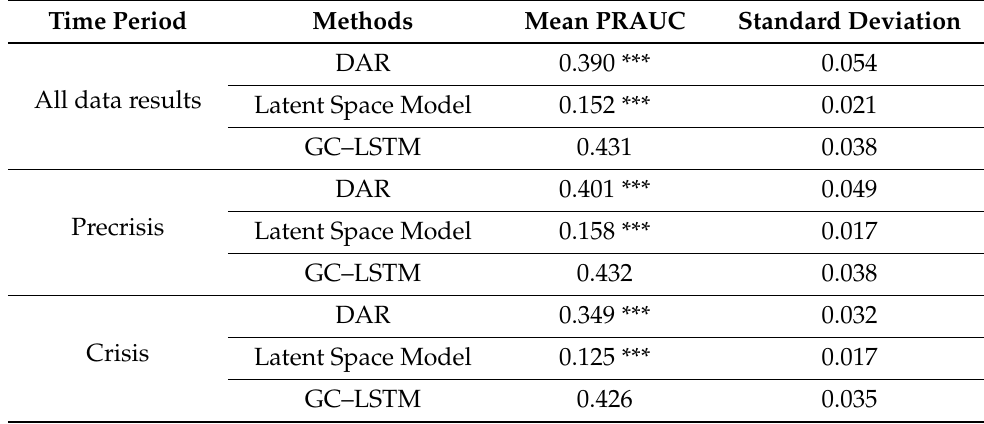
Table 4. PRAUC score for three models in the top 100 Italian banks. The significance level of 1% (***) is used to assess the mean difference between the benchmark models (DAR or Latent space model) and the GC–LSTM model with the t -test.